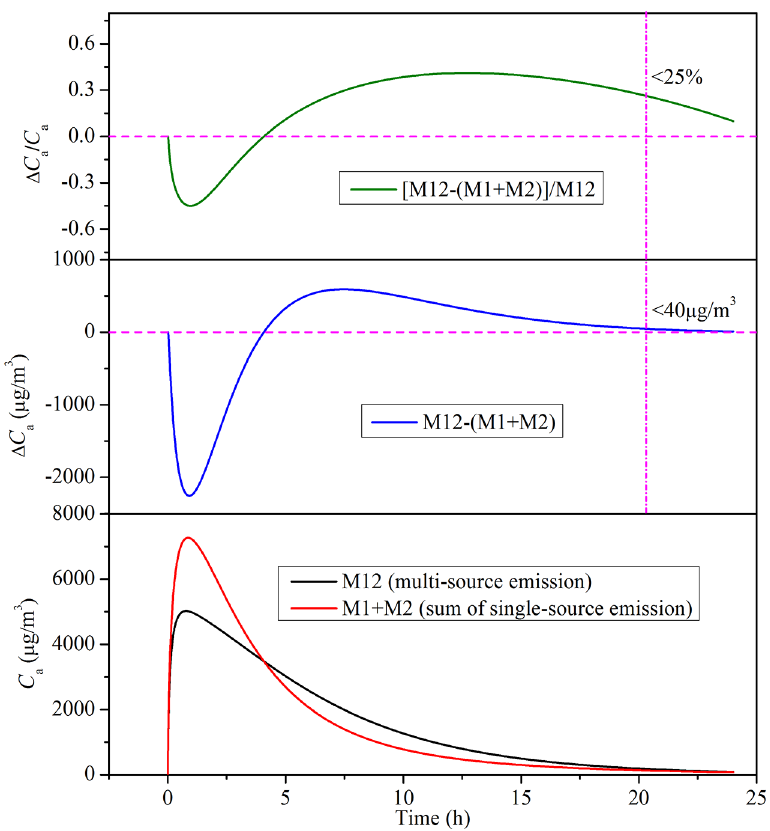
Fig 9. Comparison of chamber VOC concentration between two-source emission and single-source